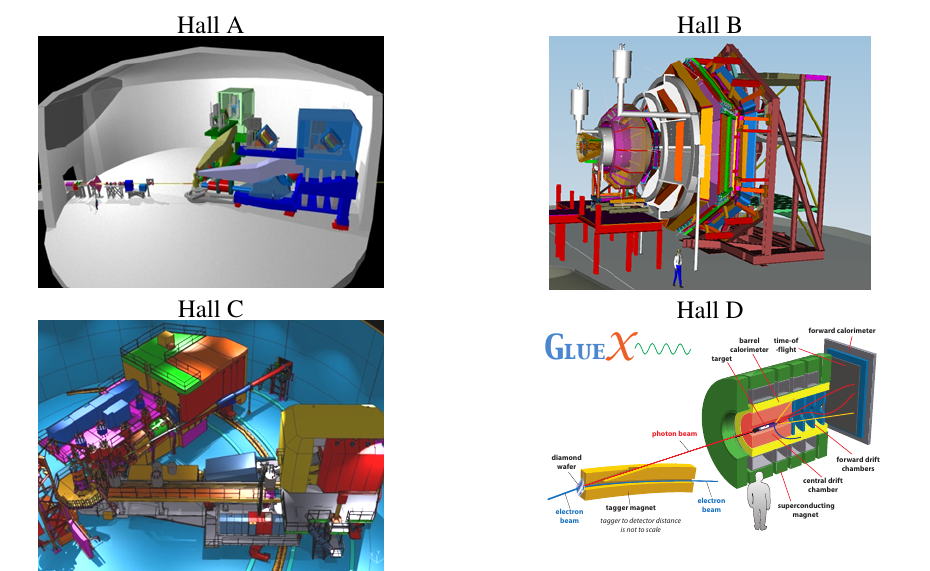
Figure 2. Experimental halls. The beamlines to halls A – C have been upgraded to 11 GeV. Hall A basic equipment was not upgraded. The CLAS spectrometer in Hall B was removed and a new CLAS12 spectrometer installed. In Hall C a new SHMS high-resolution spectrometer was installed. Hall D is a completely